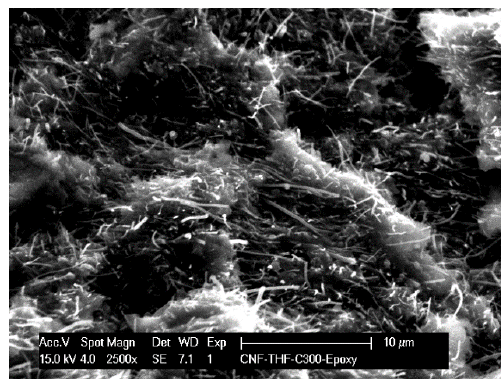
Figure 1. SEM image of the HKUST-CNF composite electrode.